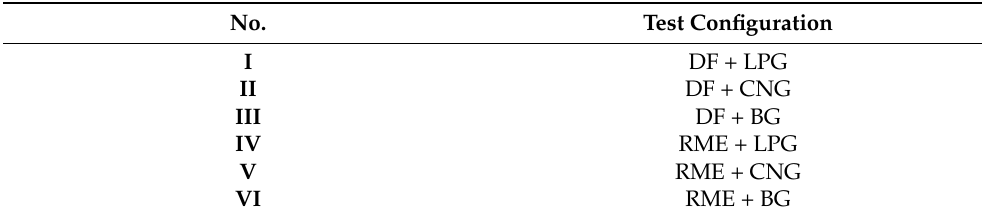
Table 6. Chemical composition of